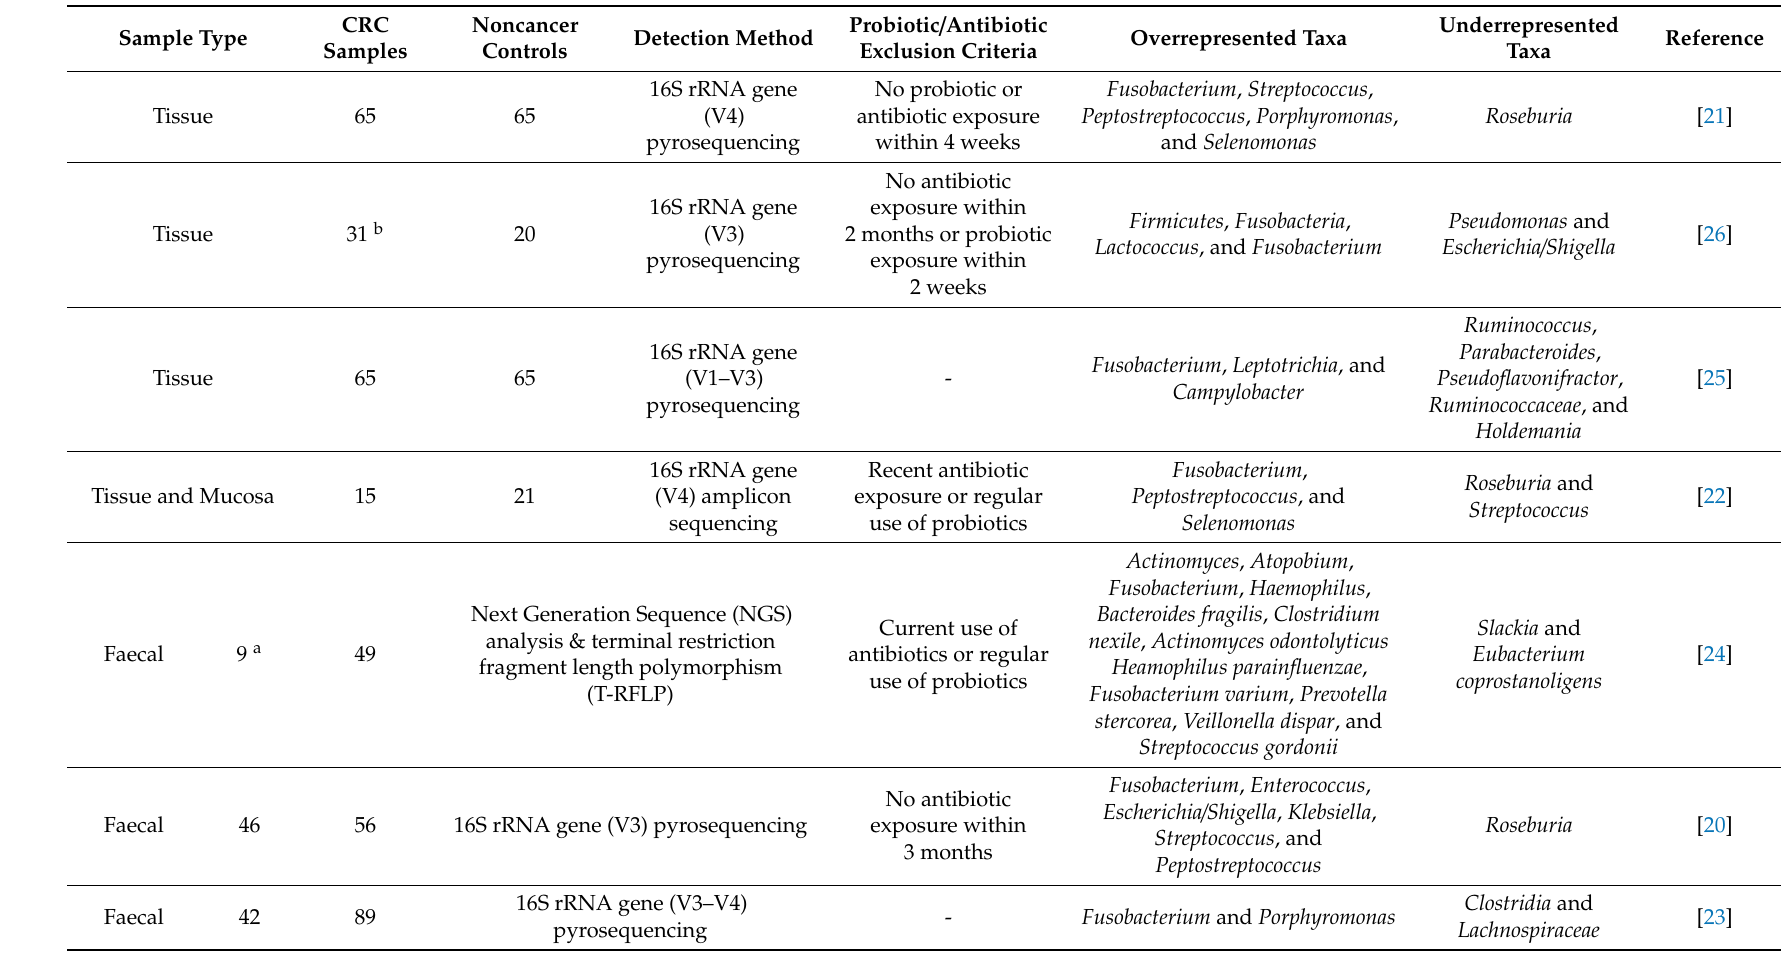
Table 1. Examples of microbial patterns observed in colorectal cancer (CRC)